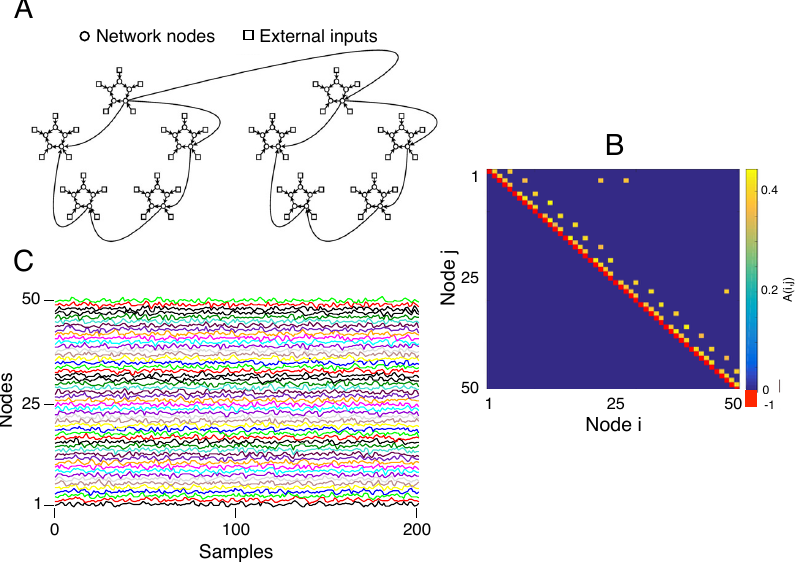
Figure 5: Simulated fMRI network from Ref. [19]. Panel A depicts the topology and Panel B the adjacency matrix of the interactions of the nodes, where negative values (labeled red) correspond to self-interactions. Connections are directed: a node in the upper diagonal of the matrix denotes a directed connection from a lower-numbered node to a higher-numbered one. Panel C shows an example of the BOLD time series simulated on this